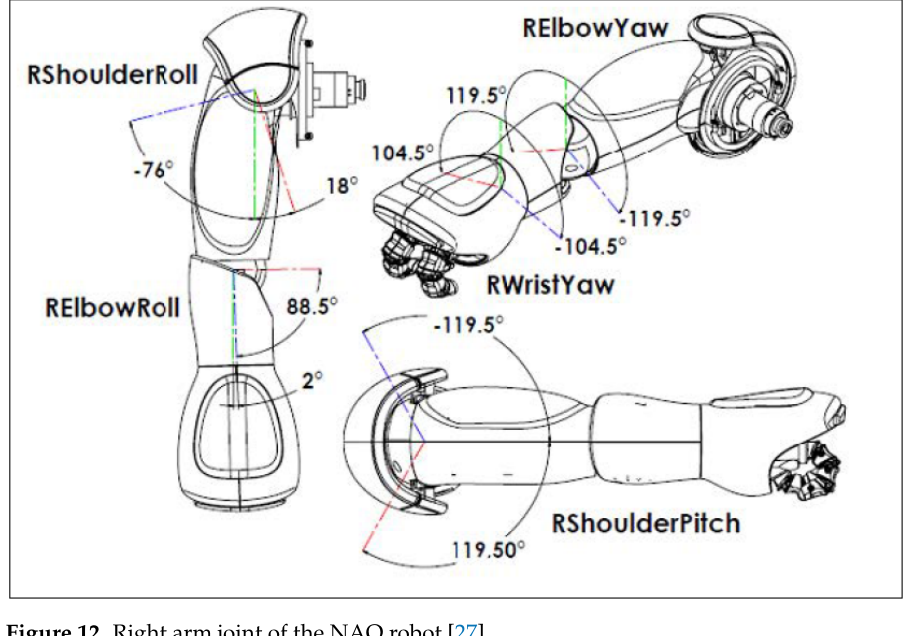
Figure 12. Right arm joint of the NAO robot [27].